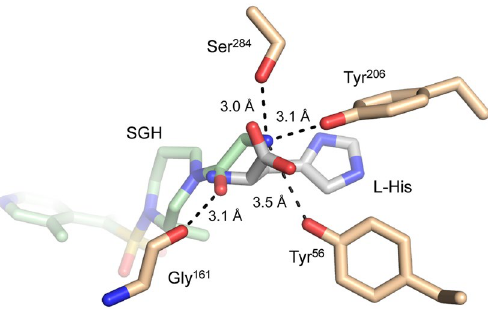
Figure 9. Superposition of M. tb EgtD-SGH (green) and EgtD-L-Histidine (gray) structures. Side chains forming the α-carboxylate binding site (tan carbons) readily accommodate a primary amine and amide linkage in the SGH complex. Binding modes similar to this region of SGH are likely in the HD4 and HD5 complexes.